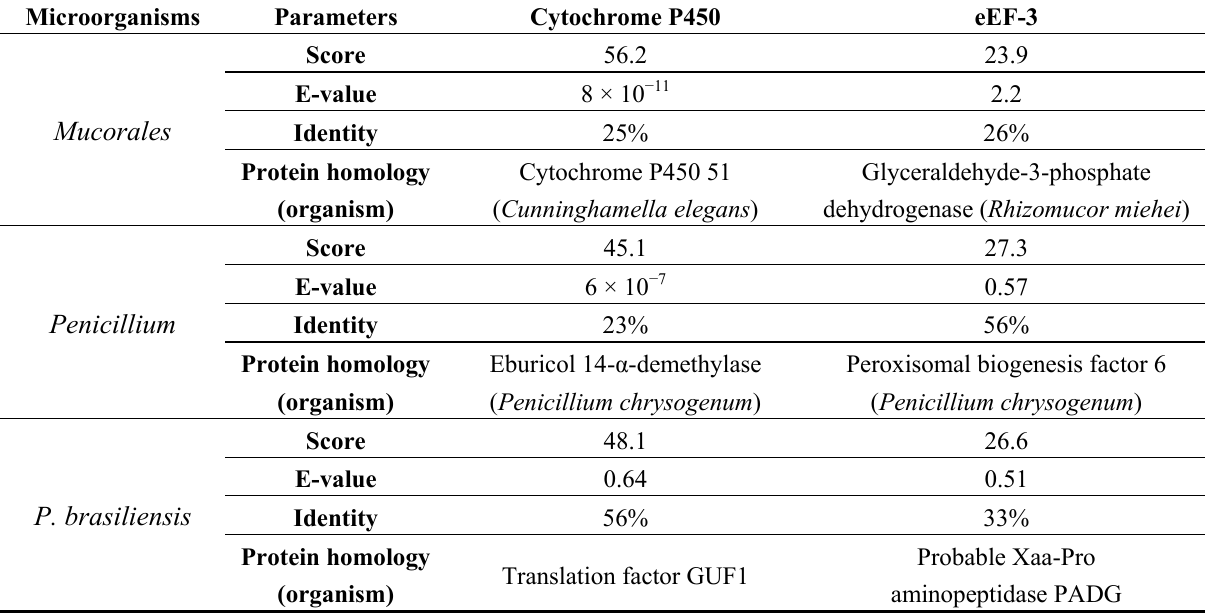
Table 3. BLAST analysis of the two main antigens identified against the protein sequences of etiological agents of other invasive fungal